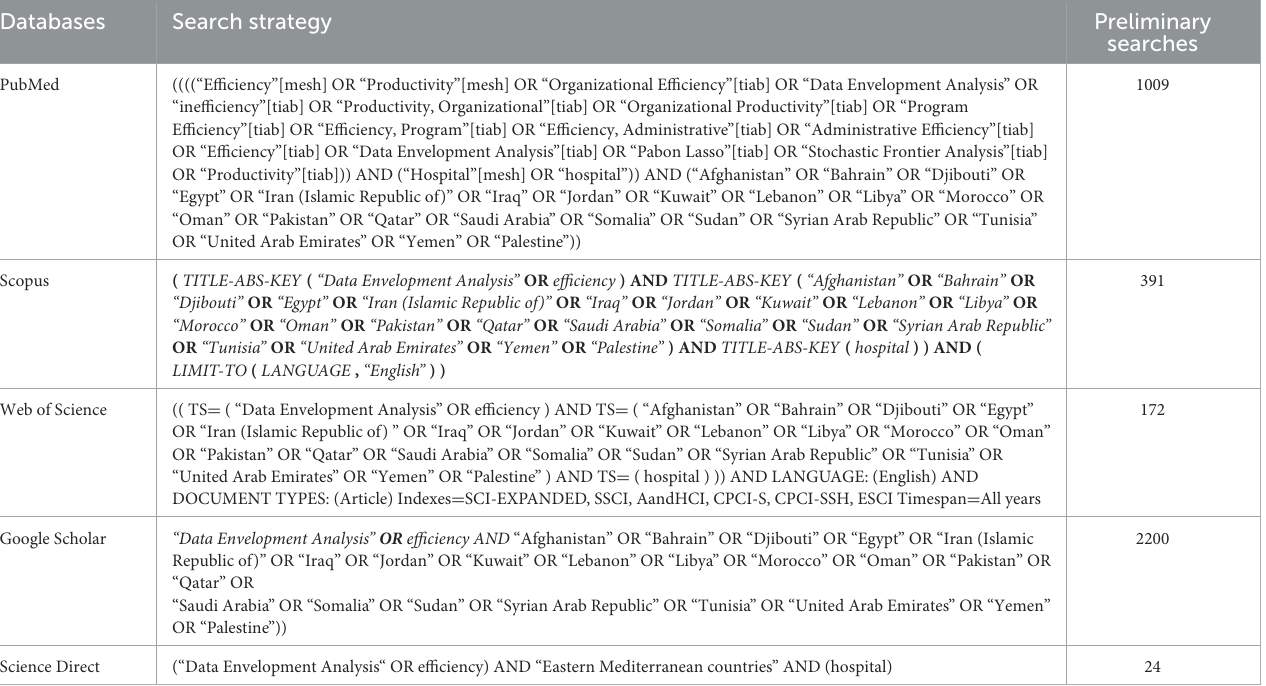
TABLE 1 Search strategy specific to the international electronic